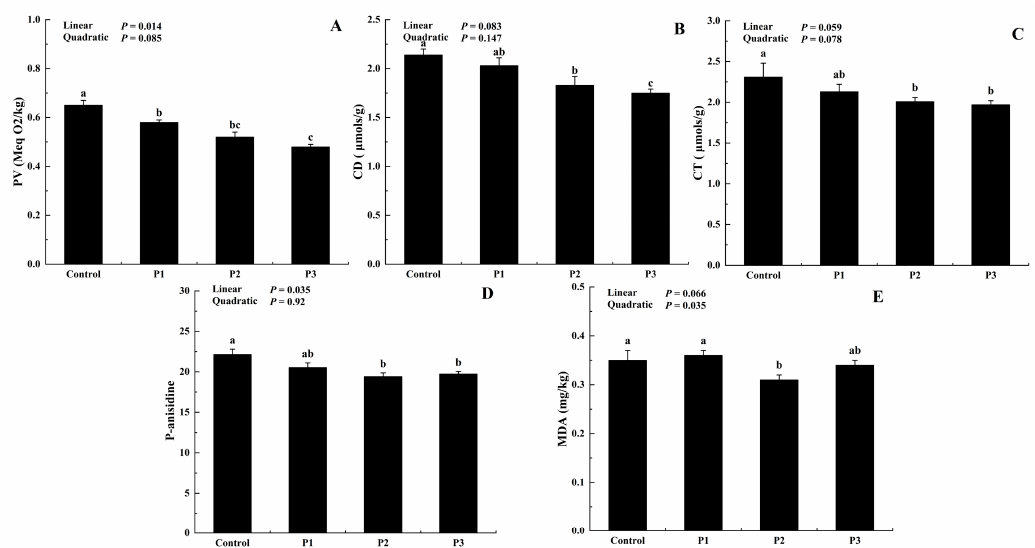
Figure 3. Effect of dietary dried jujube fruit powder (DJFP) supplementation on the products of lipid oxidation of the broilers. ( A ) Effect of dietary DJFP supplementation on the Peroxide value of the broilers. ( B ) Effect of dietary DJFP supplementation the conjugated dienes value of the broilers. ( C ) Effect of dietary DJFP supplementation on the conjugated trienes value of the broilers. ( D ) Effect of dietary DJFP on the Para anisidine of the broilers. ( E ) Effect of dietary DJFP supplementation on the MDA content of the broilers. Control, P1, P2, and P3 diets contained 0, 50, 100, and 150 g/kg of DJFP in the diet, respectively. MDA, malondialdehyde. a–c Values with different letters above the column mean significant difference ( p <